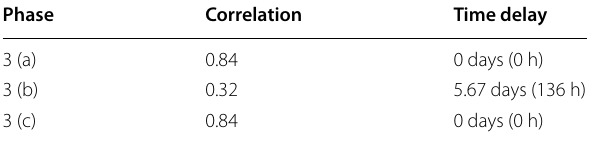
Table 2 Functional correlations and the time measured in days, where the correlation measure is maximum by considering three sub‑phases in the third phase Phase